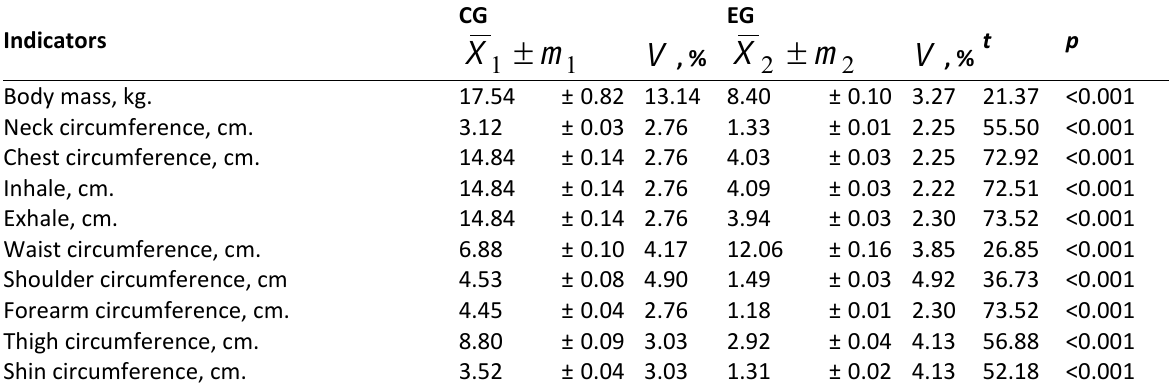
Table 6. Mean indicators of anthropometric data reduction in CG and EG elite bodybuilders in competition period (n 1 = n 2 =8)